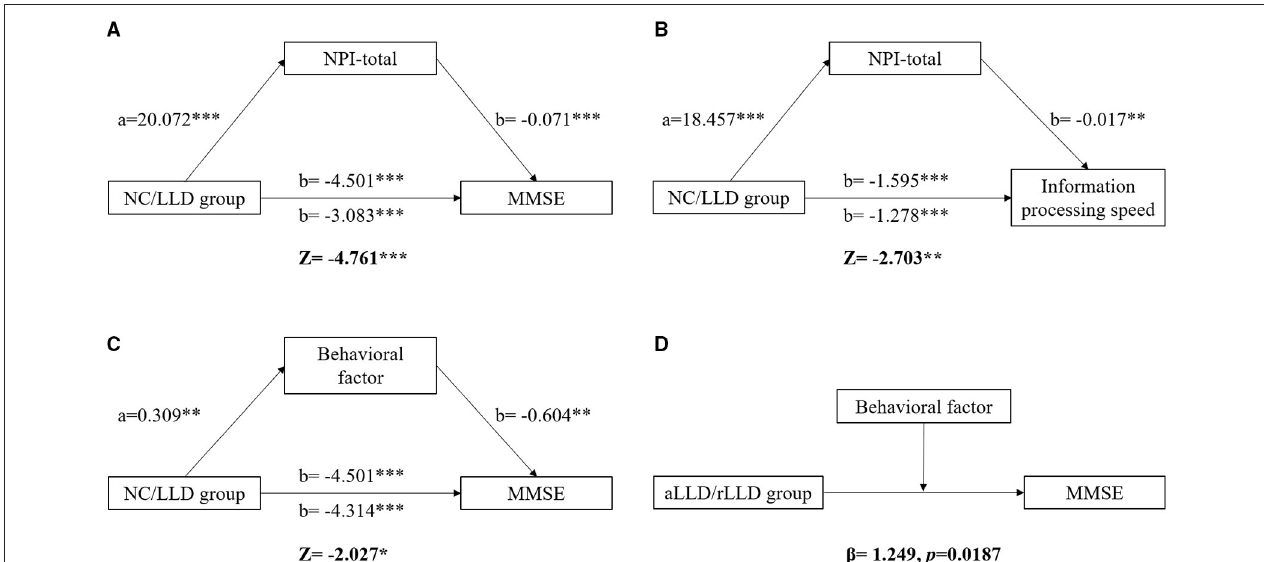
FIGURE 2 | The mediating and moderating effect of NPS on cognition. Differences of MMSE and information processing speed between NC and LLD groups were mediated by NPI-total (A, B) . Difference of MMSE between NC and LLD groups was also mediated by behavioral factor (C) . The NPI-total and behavioral factor are both the partial mediator for the relationship between NC/LLD groups and the cognitive functions. The MMSE difference between aLLD and rLLD groups was moderated by behavioral factor (D) . Behavioral factor played a greater effect on impairing MMSE in rLLD group than in aLLD group. * p < 0.05; ** p < 0.01; *** p <